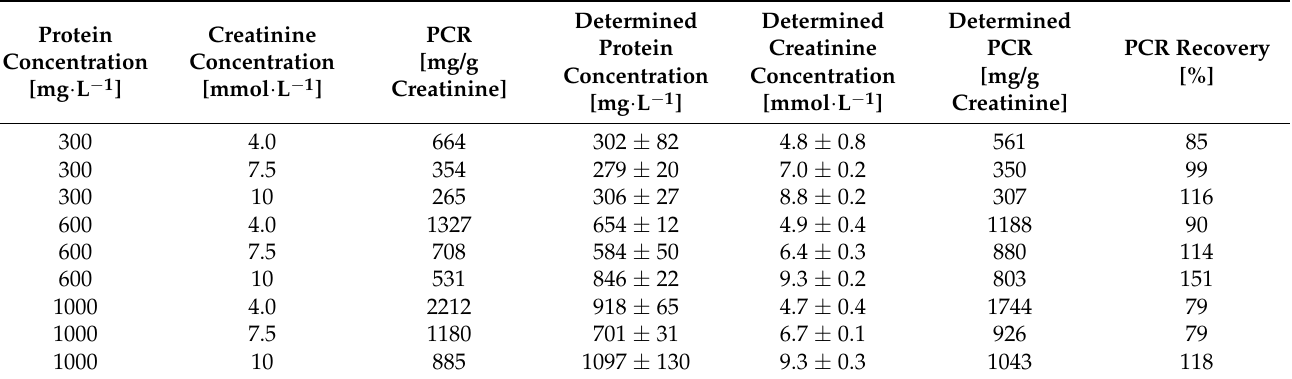
Table 4. Protein to creatinine ratio recovery study in artificial urine, n =